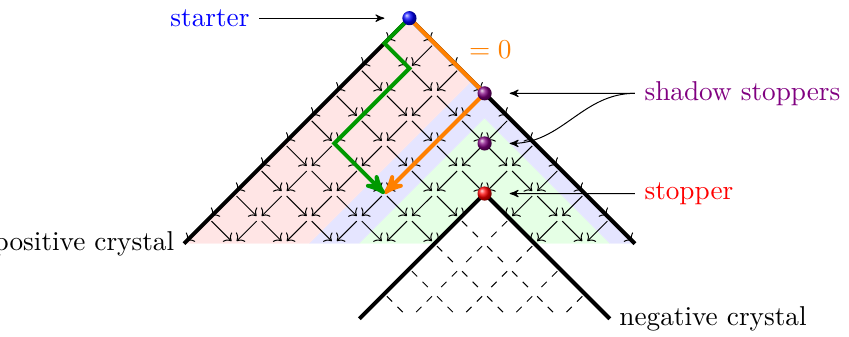
Figure 3 . The irreducibility of the representation requires the stoppers of the subcrystal to have relative depth-zero. In this figure, this condition is violated, leading to three irreducible components, depicted in three different colors (pink, blue, and